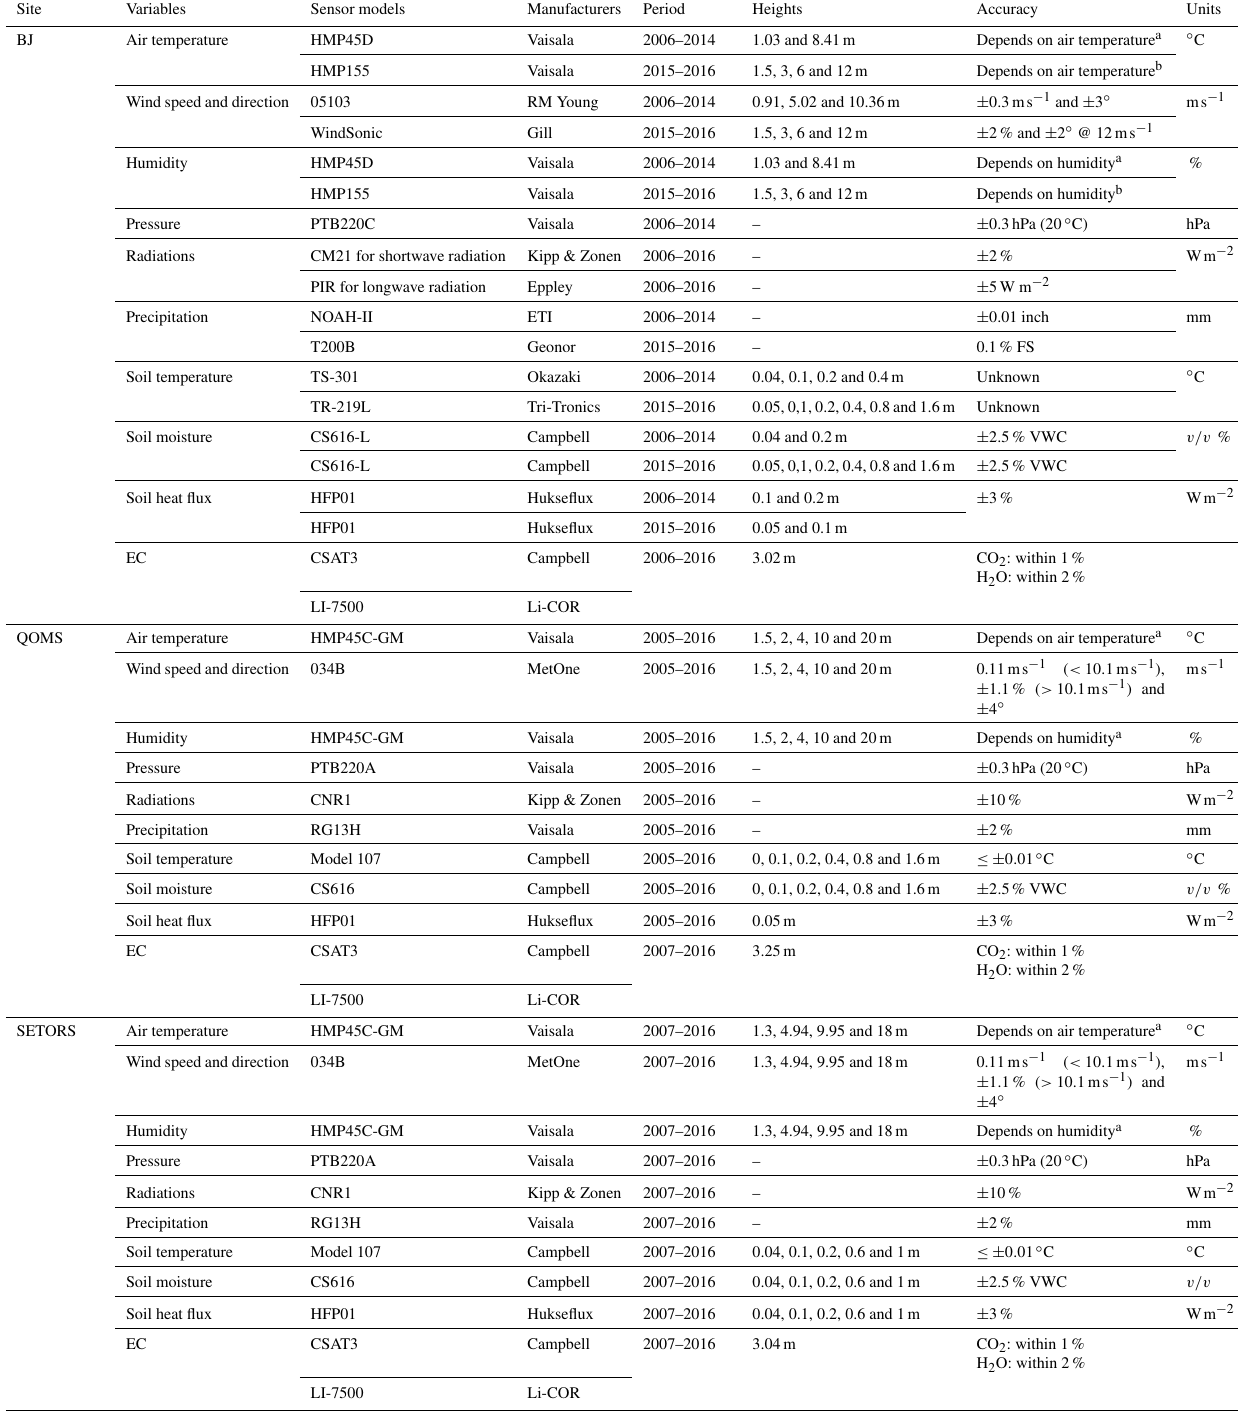
Table 2. Overview of the sensors used at each